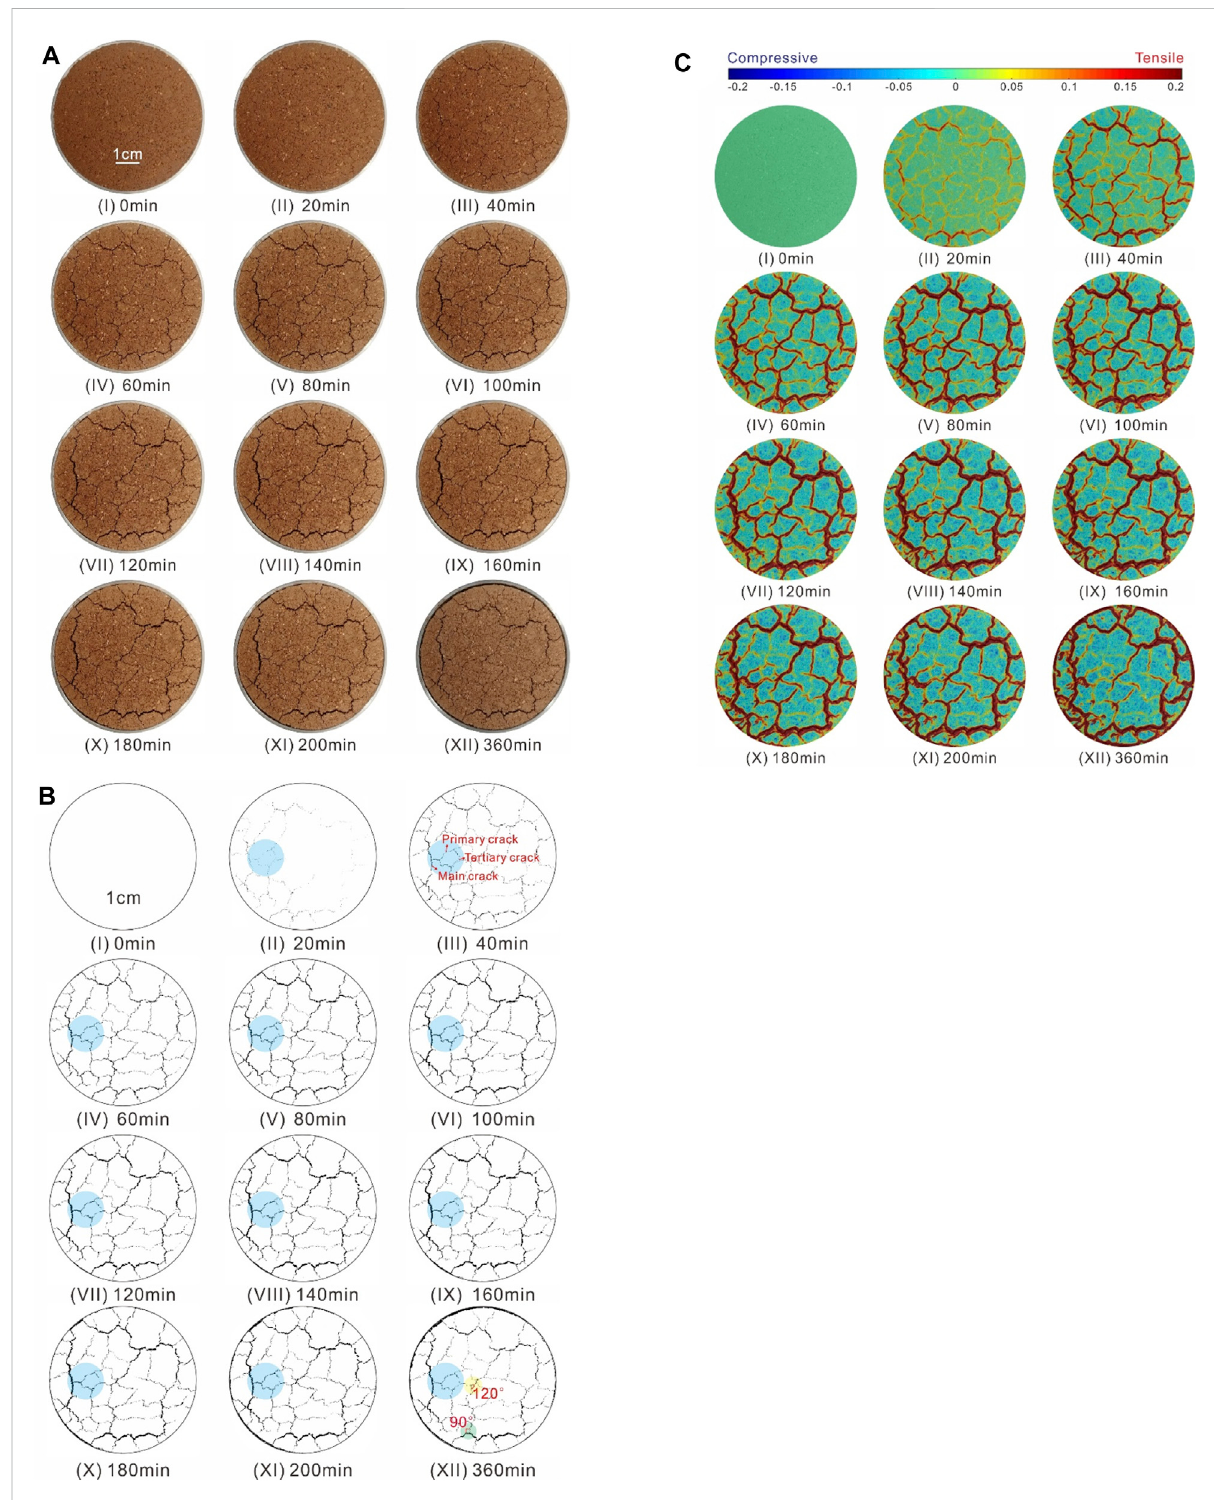
FIGURE 5 Evolution of desiccation cracks for compactedspecimen with initial dry density of 1.50 g/cm 3 and initial moisture content of 22%. (A) Evolution of crack patterns on the top surface of specimen, (B) Evolution of cracks of specimen analyzed by PCAS, and (C) Strains fi eld variations of specimen surface during